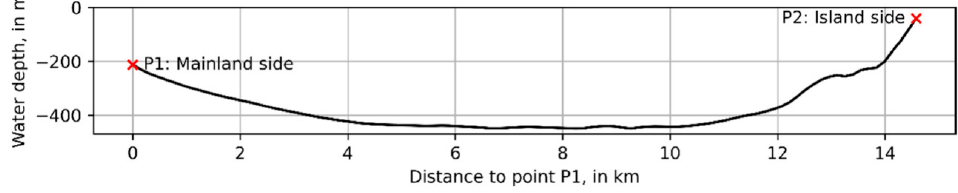
Figure 7. Bathymetric cross section of the Cozumel Channel. 5 times vertically enlarged.